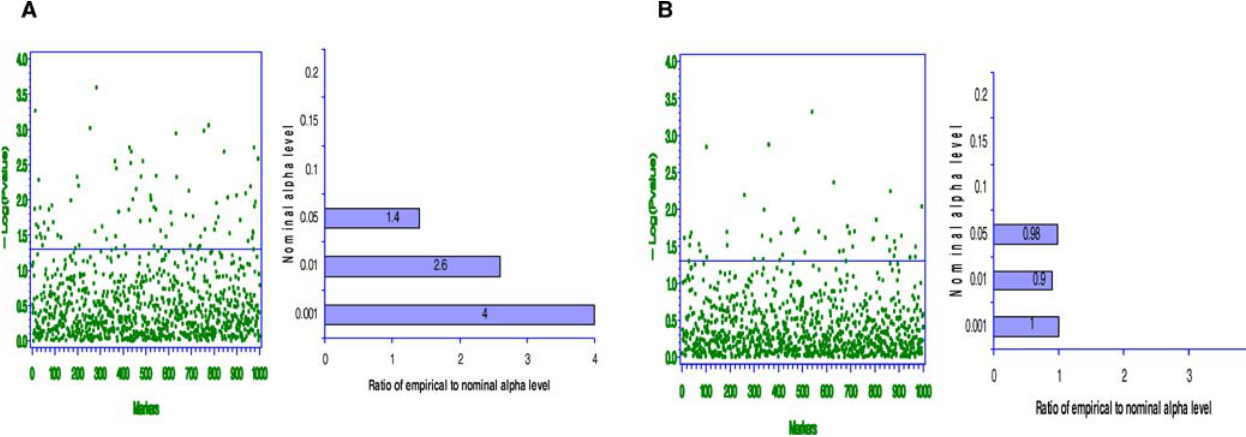
Figure 5. The Importance of Accommodating Measurement Error in Models The dataset used to create this graph was generated under the same conditions as used to generate the data for Figure 2. The reliability of the available individual admixture estimates used as estimates of individual ancestry is 90%. That is, f ( r 2 = ð r 2 r 2 ] ¼ 0.9 g . [ r 2 true ancestry true ancestry þ error Þ (A) Type I error inflation caused by measurement error in the individual ancestry estimate. Ignoring possible measurement error in the ancestry estimate may also lead to a high type I error rate. (B) Observed false positive rate after correction for measurement error; in this example we used the SIMEX algorithm as described in Cook and Stefanski [70]. DOI: